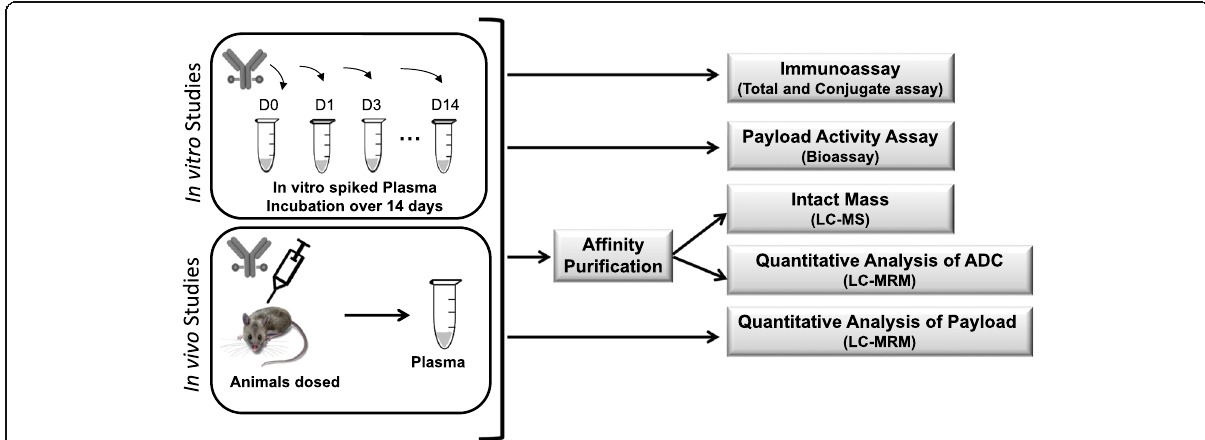
Fig. 1 Schematic illustrating the range of bioanalytical methods used in the studies described in this paper. These methods can be applied to understand concentration, activity, and intactness of antibody-drug conjugates in vitro and in